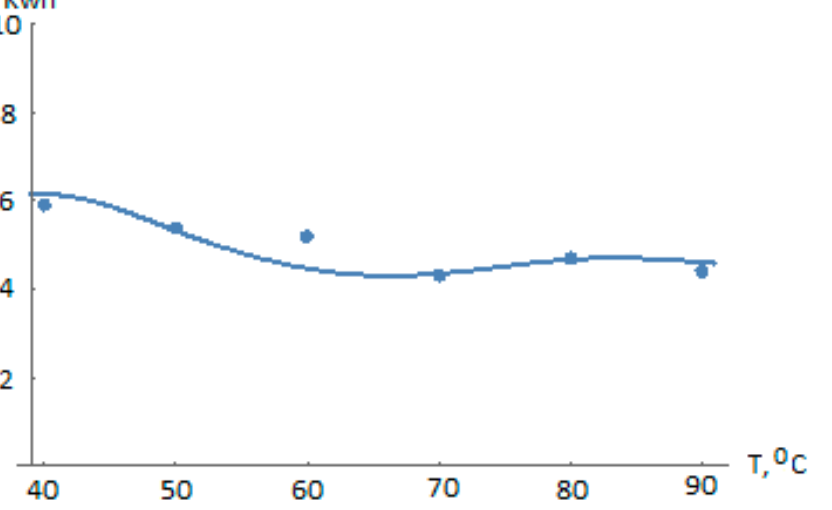
Figure 8. Comparison of the dependence K wn (120, T) calculated using the polycenteric model (activation energies from Table 3 and experimental data from Table 1; relative errors Δ 40 = 0.042, Δ 50 = 0.014, Δ 60 = 0.141, Δ 70 = 0.011, Δ 80 = 0.006, Δ 90 = 0.048).